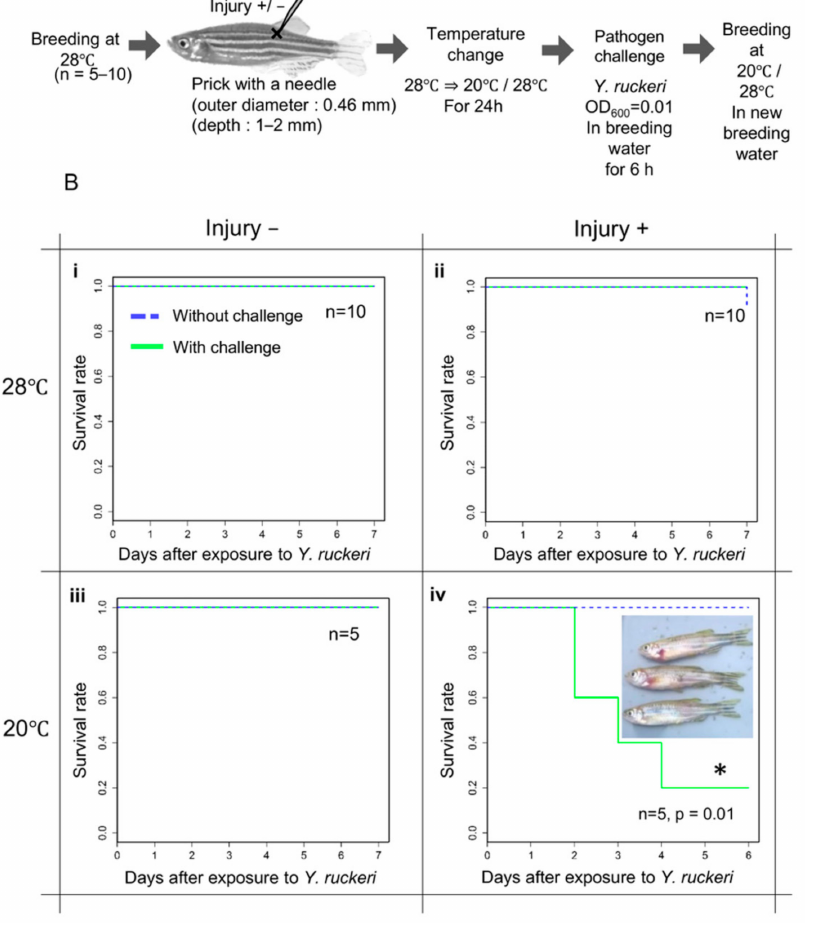
Figure 1. Procedure and results of infection experiments. ( A ) Schematic procedure of infection experiments. ( B ) The survival rate of zebrafish in infection experiments. Surviving fish under each experimental condition were counted daily for seven days after being challenged with Y. ruckeri . The survival rate of zebrafish subjected to pathogen challenge (green line) was compared with that of zebrafish that were not challenged (blue dotted line). Inset image: dead fish previously challenged with Y. ruckeri . *; Significant difference against a control group by log rank